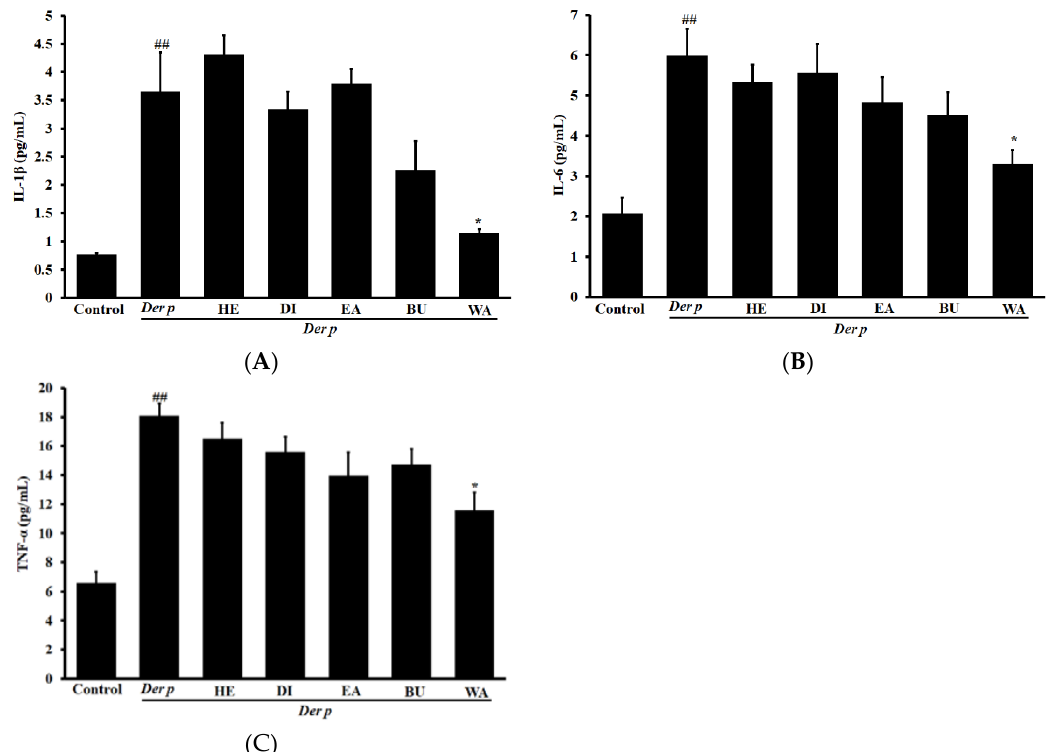
Figure 6. Effects of different fractions of garlic extracts (80 mg/kg) on ( A ) IL-1β, ( B ) IL-6 and ( C ) TNF- α pro-inflammatory cytokine levels in the collected lung tissue of mice with Der p–induced allergic asthma. Data derived are presented herein as mean ± SEM. ## p < 0.01 versus the control group, * p < 0.05 versus the Der p group.